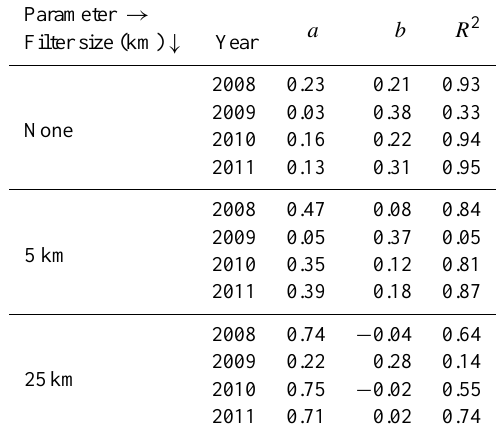
Table 3. Linear fit statistics for pFCu vs. EVI dependencies using no filter and 5 and 25km spatial disk filters on the EVI data, for years 2008–2011. Statistics include linear fit slope ( a ), point of in- tersection with y axis ( b ), and the R 2